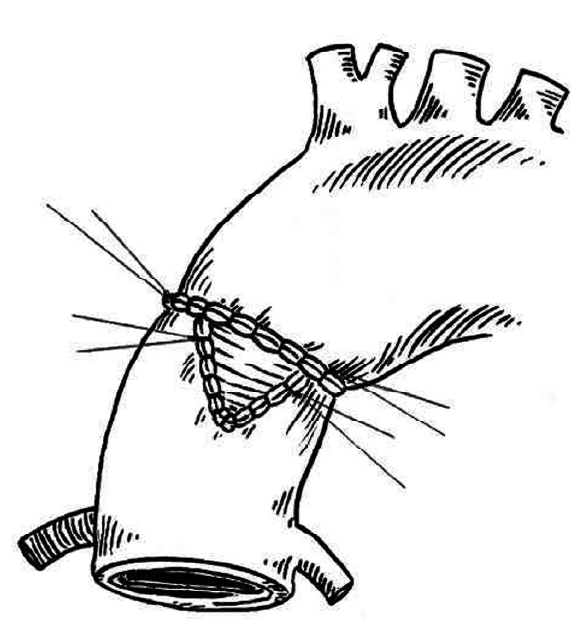
Fig. 2 – Ilustração da correção da estenose supra-aórtica adquirida com patch de pericardio bovino.